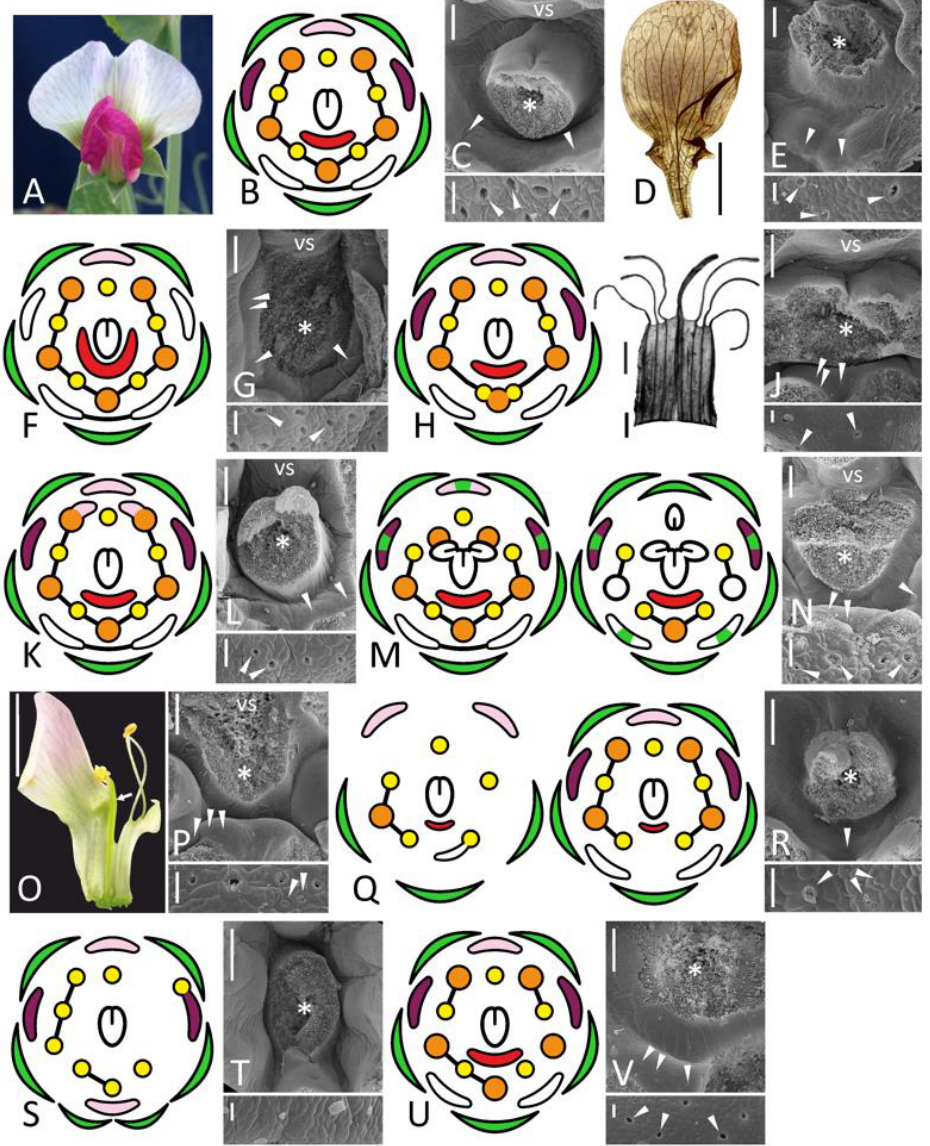
Figure 1. Morphology of flowers and FNs in studied accessions of Pisum sativum represented by floral diagrams ( B , F , H , K , M , Q , S , U ), SEM images ( C , E , G , J , L , N , P , R , T , V ), and details of macromorphology ( A , D , I , O ). In each SEM image, the upper part represents an overall top view, while the lower part is a closer view of secretory area or a similar region in nectarless flower ( T ). All SEM images are oriented with an abaxial side downwards. ( A – C ), wild-type flower of a recombinant from F 2 JI2163 × WL1749; ( D , E ), cv. Anvend with unusual symmetric wings ( D ); ( F , G ), k recombinant; ( H – J ), uni tac mutant [in ( I ), vexillary stamen is not shown]; ( K , L ), sup recombinant; ( M , N ), stp-1 mutants with mild ( M , left) and severe ( M , right) phenotype; ( O , P ), stp-1 sup recombinant; ( Q , R ), biv recombinant [in ( Q ), left diagram represents severe floral phenotype, while right diagram is a weak phenotype]; ( S , T ), severe coch phenotype (JI2758; all stamens are represented as inner, as their position was unclear); ( U , V ), weak coch phenotype (Wt11304). Key: green color = sepal; pink color = flag; purple color = wing; white color = keel; red color = secretory area; orange color = outer stamen; yellow color = inner stamen; line between organs on diagram = fusion (not shown in a calyx); arrowheads = exemplary nectariferous stomata; asterisk = carpel base or place where it was attached; vs = vexillary stamen. Scale bar: 1 mm ( D , O ), 0.2 mm ( I ), 300 μm (upper parts of all SEM images), 30 μm (lower parts of all SEM images). Photos: Polina Mamoshina ( A ), Elina Shnayder ( O ).